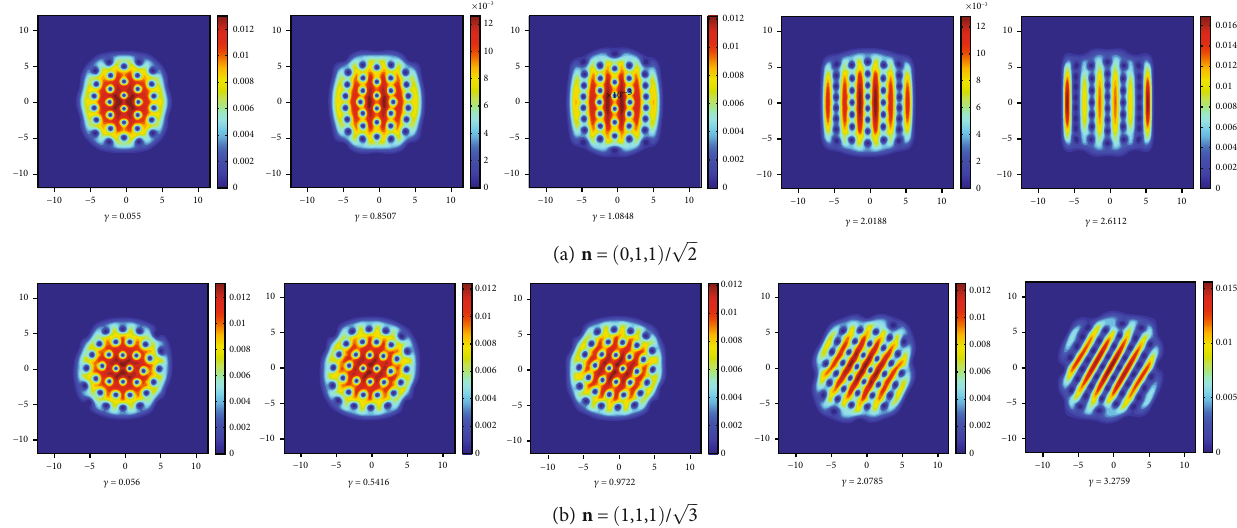
ffiffiffi p 5 , ω = 0 : 9 , β = 500 ,